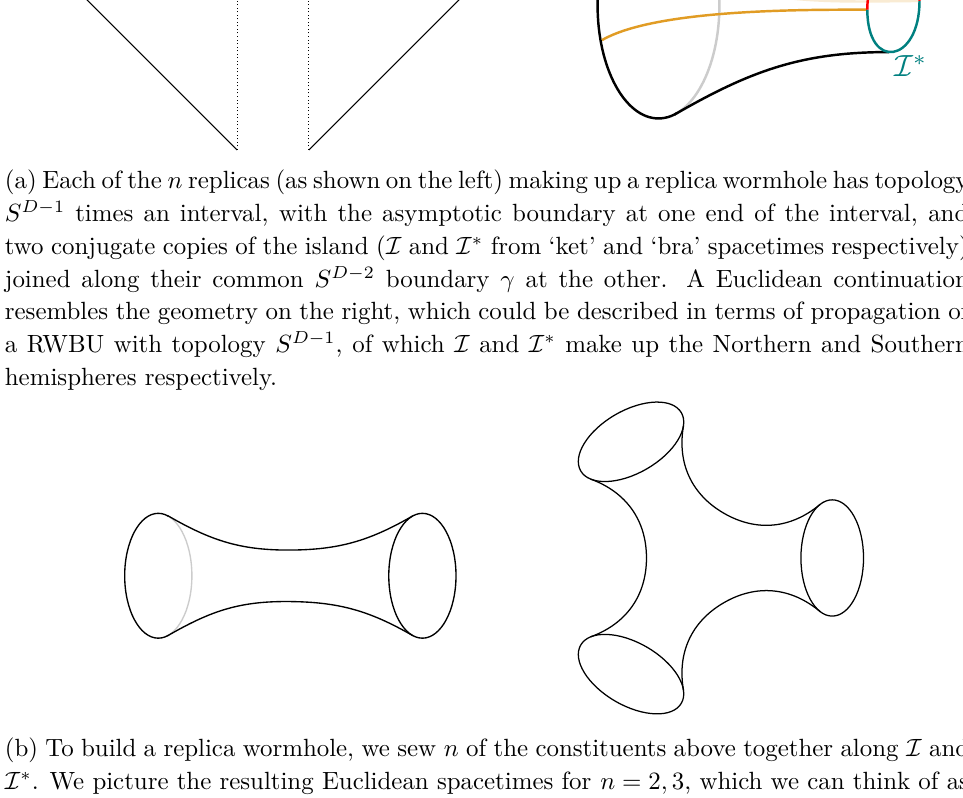
Figure 20. We may describe the correlations between sets of Hawking radiation arising from replica wormhole spacetimes as mediated by exchange of ‘replica wormhole baby universes’ (RWBUs) appearing in intermediate states such as ˆ ρ ij ( u ) | HH i ∈ H BU . Such a state is somewhat unusual in Lorentzian signature, but has a natural Euclidean